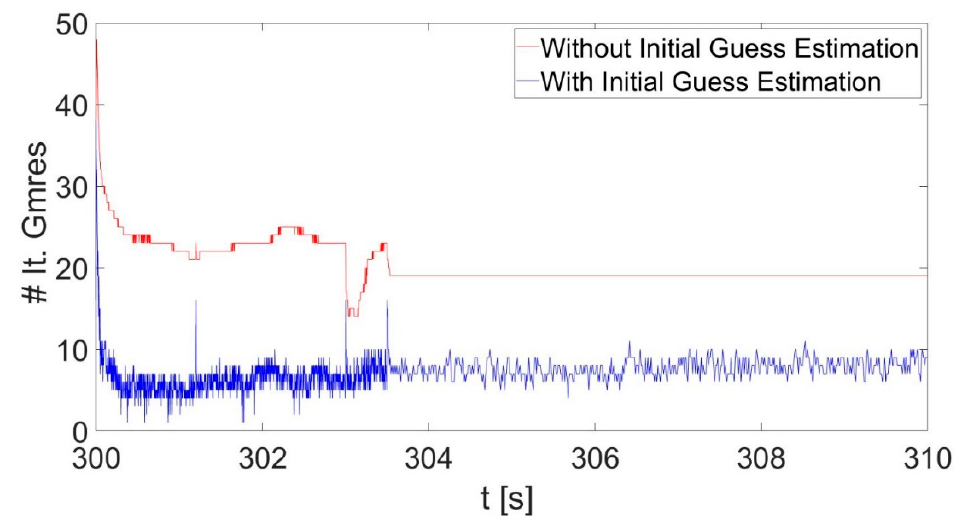
Figure 14. Testcase#1. The number of GMRES iterations required to converge to a relative error equal to 1 × 10 − 5 , versus time, with and without initial guess estimation.